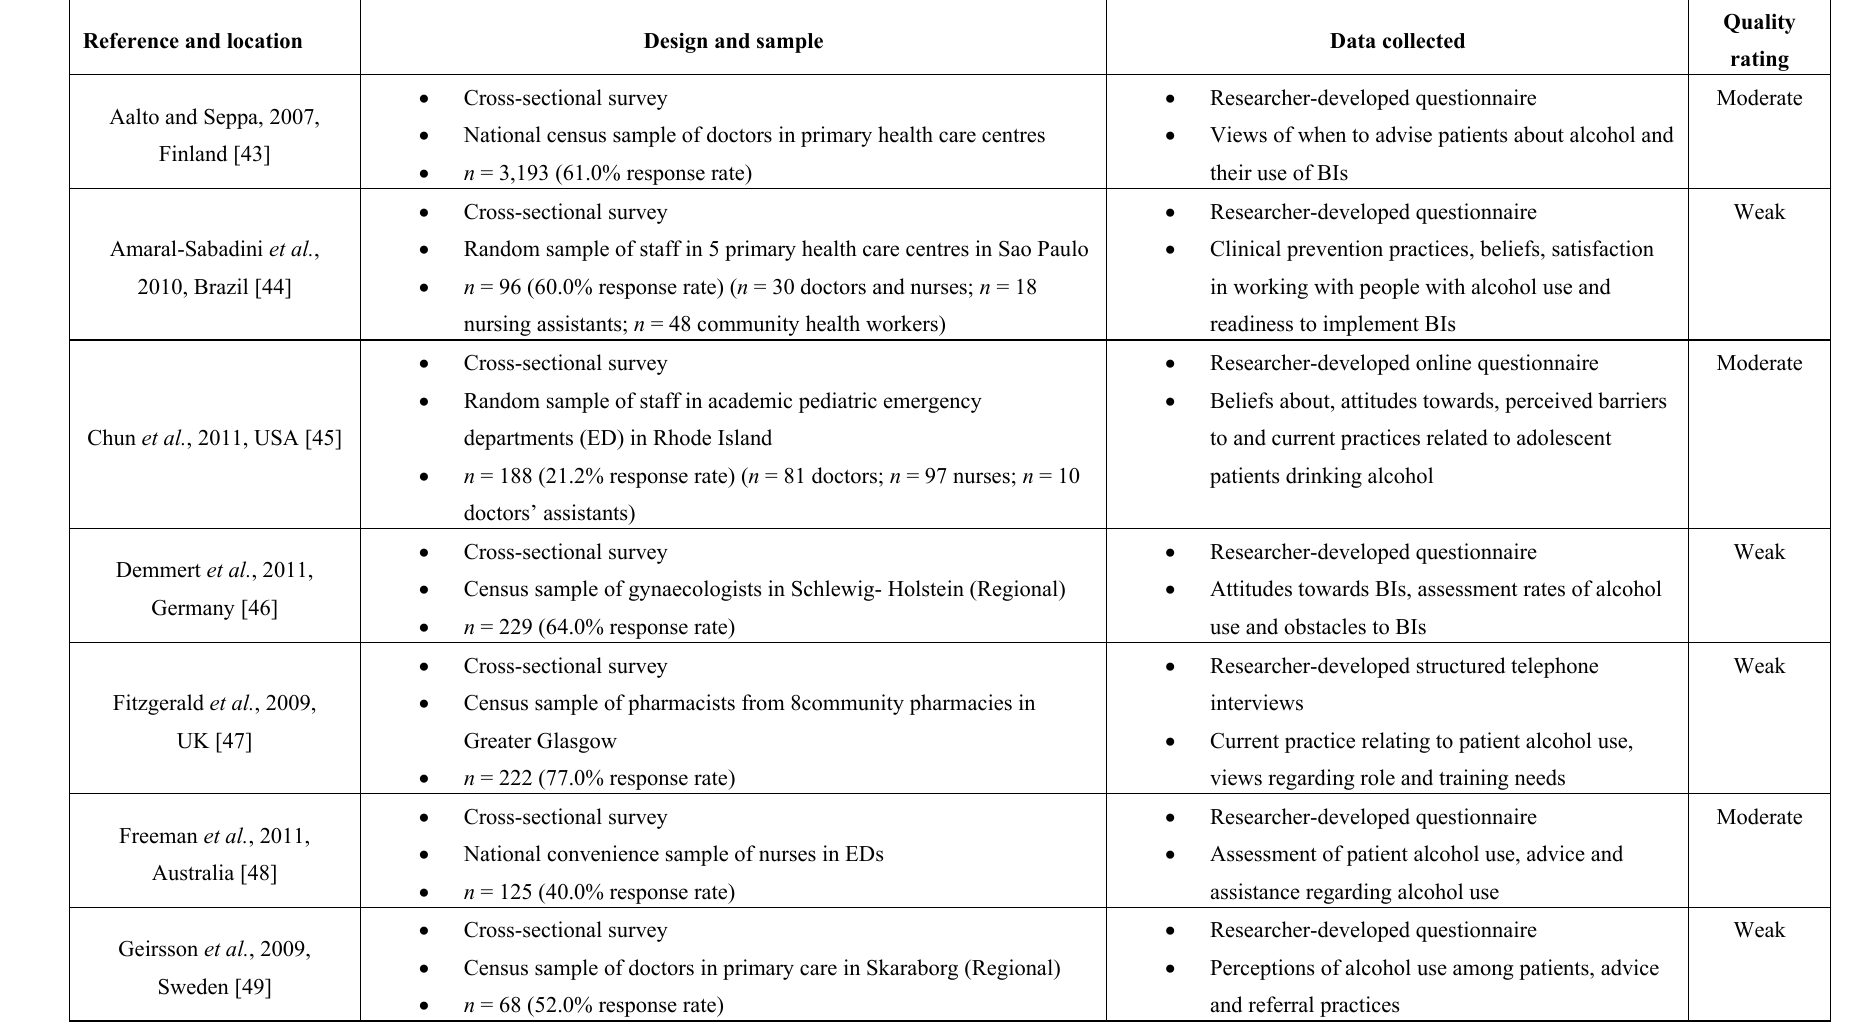
Table 3. Professional alcohol-related health promotion practices: Summary of studies